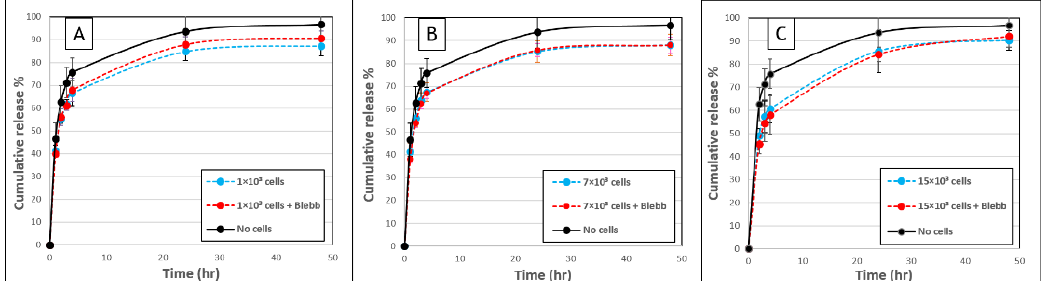
Figure 5. Fibroblast-induced forces do not modulate the release of FD 250 kDa from fibrin gels. ( A ) FD release from fibrin gels with ( A ) 1 × 10 3 cells, ( B ) 7 × 10 3 cells or ( C ) 15 × 10 3 cells that were untreated (blue, dashed line), or treated with blebbistatin (red, dashed line), over a 48-h period. Untreated acellular gels served as controls (black, continuous line). No statistically significant difference was observed between cellular gels with versus without blebbistatin ( p > 0.05). The values represent the mean ± SD of 8 gel replicates for each of the cellular gels and 21 gel replicates for the “no cells”